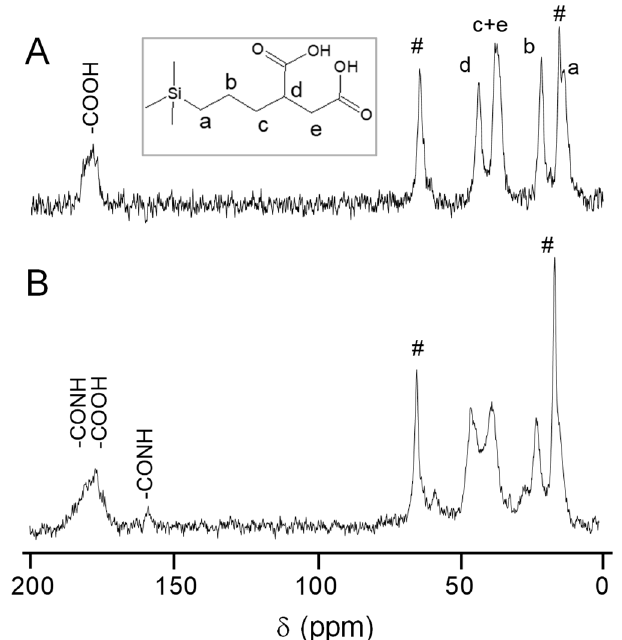
Figure 2. 13 C { 1 H} cross polarization (CP) MAS NMR spectra of materials: ( A ) MSNs-COOH ext and ( B ) MSNs-LprG. Peaks designated with # correspond to ethoxy groups due to incomplete hydrolysis and condensation.